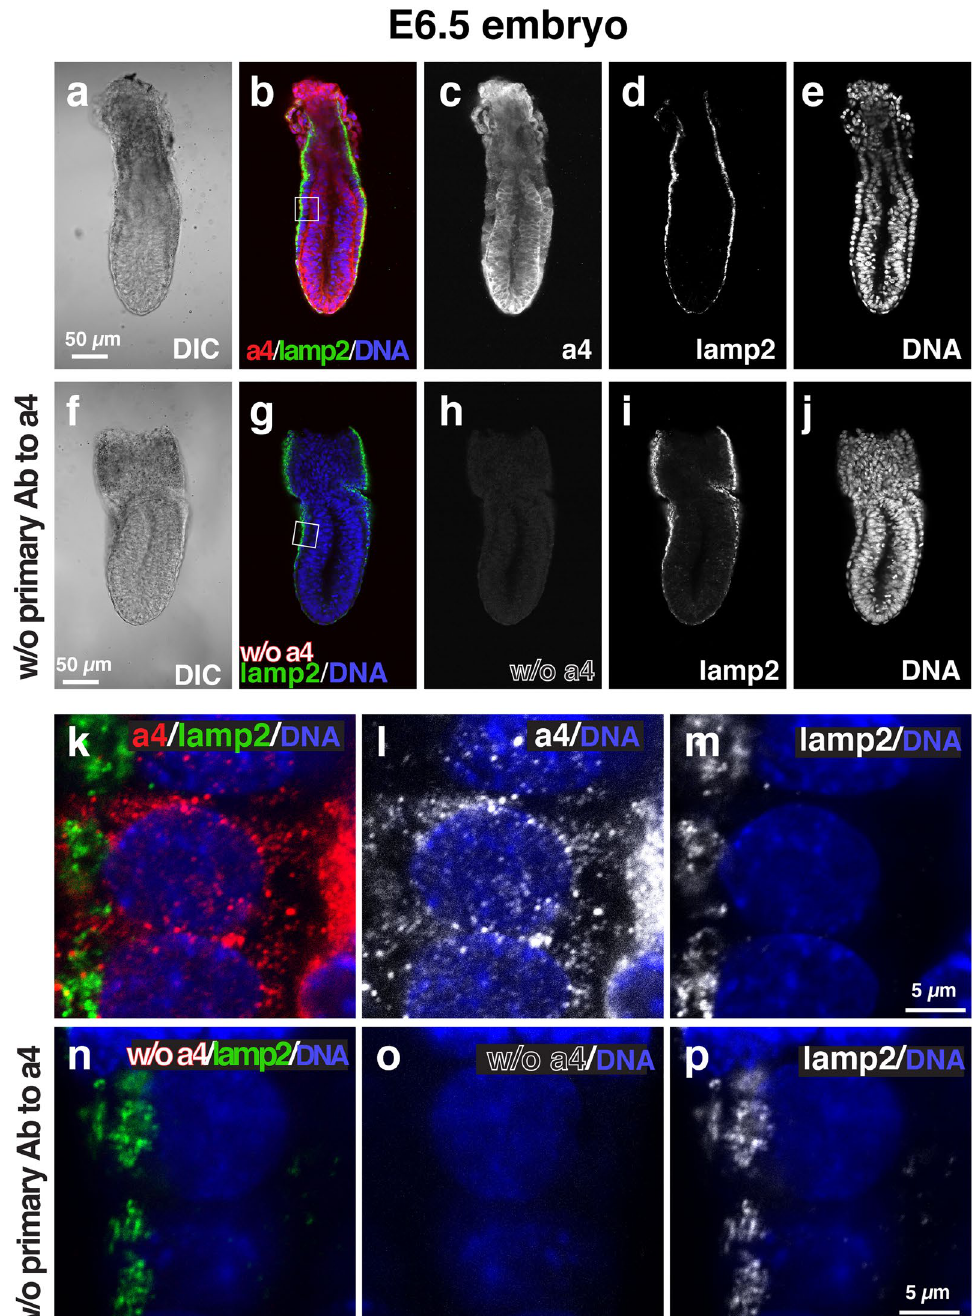
Figure 5. Localization of a4 subunit isoforms in mouse E6.5 embryos. Wild-type E6.5 embryos (n = 8) were isolated and stained with antibodies against a4 (red) and lamp2 (green). Nuclear DNA is also labelled (blue). The control embryos (n = 5) labelled without the primary antibodies against a4 (w/o primary Ab to a4) was shown in ( k – j,n – p ). The secondary antibody alone controls in which the embryos were labelled without primary antibodies against the a4 isoform were performed in parallel and the images were obtained under the same microscopic setup. The boxed region in ( b , g ) is magnified and shown as ( k – m , n – p ), respectively. Scale bars represent 50 µm and 5 µm in ( a – j , k – p ),